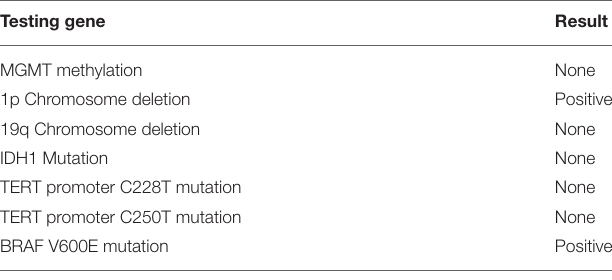
TABLE 3 | Major Findings of Genetic Variant Analysis by Gene